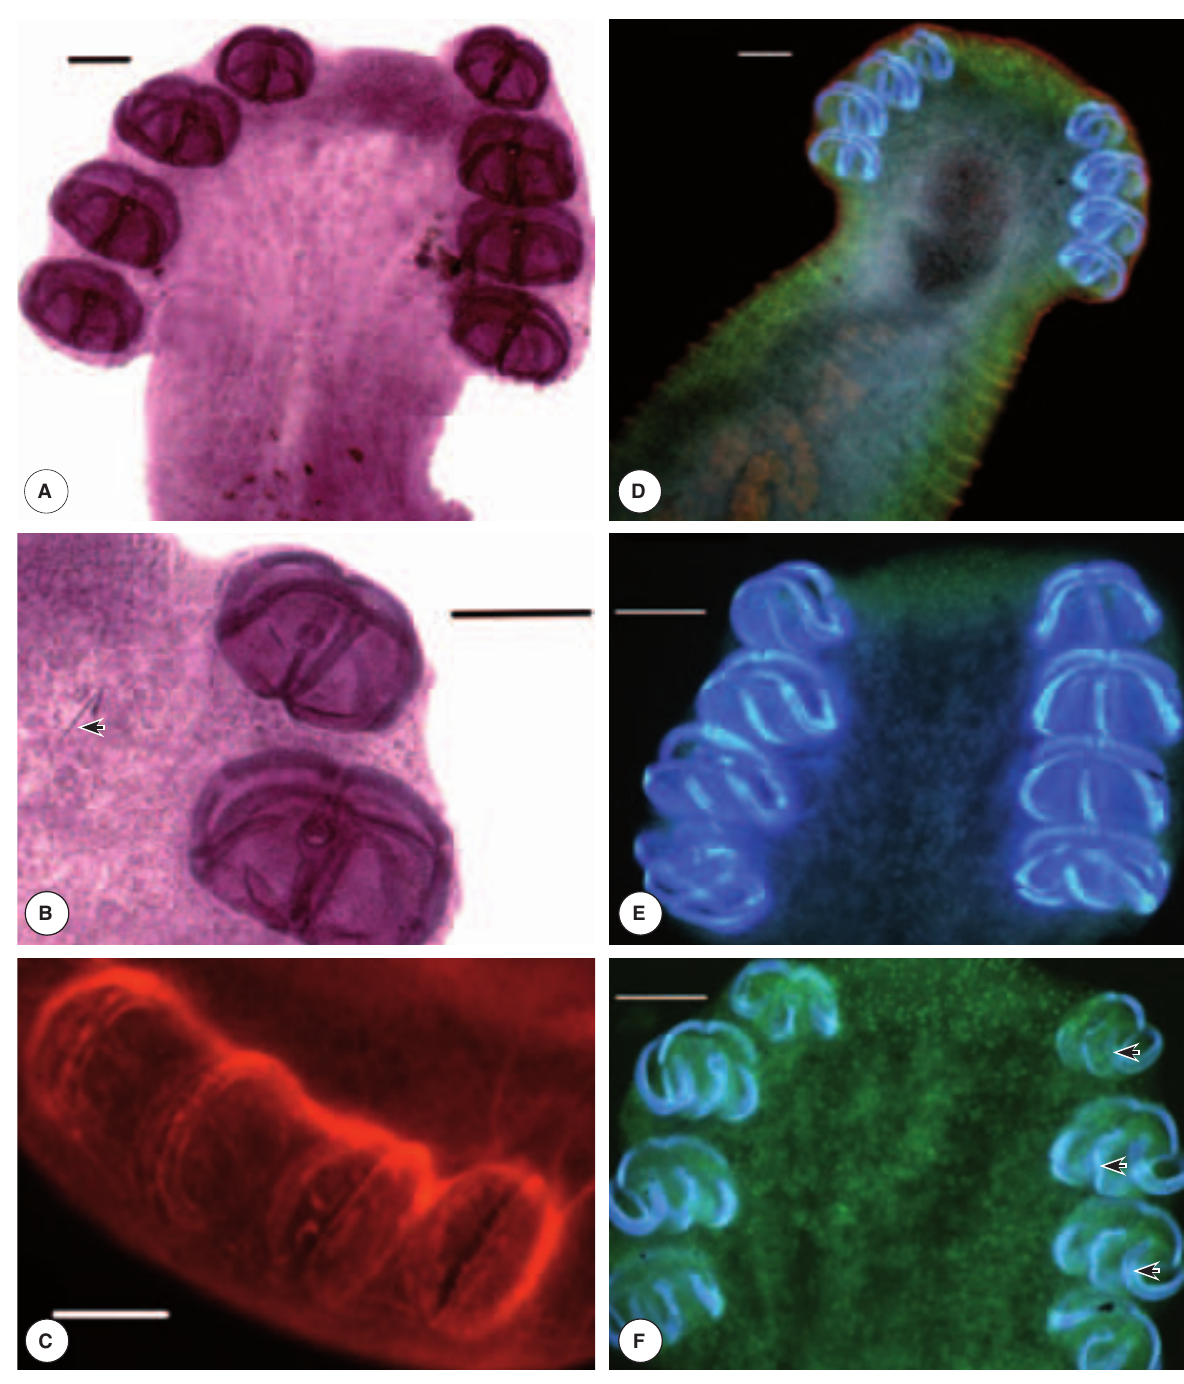
FIG. 1 Photomicrographs of Paradiplozoon morphology . Scale bars = 100 μ m A Dorsal view of opisthaptor, showing clamp morphology. Hörens trichrome stain B Dorsal view of opisthaptor, arrow indicates position of hamilus. Hörens trichrome stain C Photomicrograph of fluorescing glycocalyx after staining with WGA-1 Texas red D Photomicrograph following staining with composite fluorochromes E Dorsal view showing detail morphology of sclerites following staining with fluorochromes F Ventral view showing detail morphology of sclerites following staining with fluorochromes, arrows indicate position of thickening in the anterior